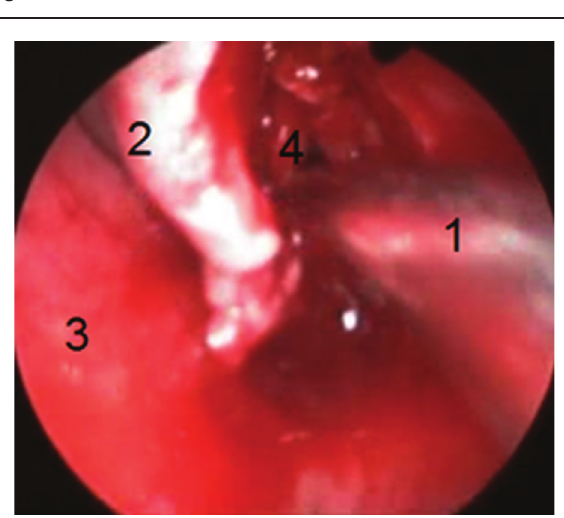
Powered turbinectomy; Rt. Side (after resection). 1) Raw area after inferior turbinectomy. 2) Nasal septum. 3) Middle